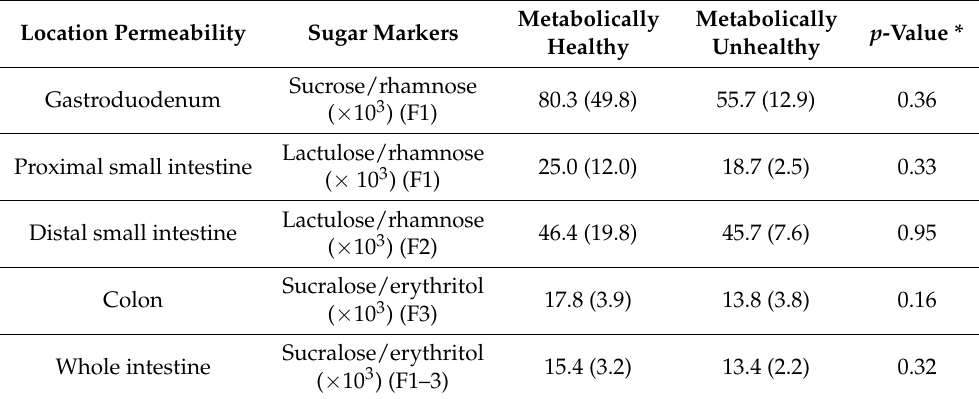
Table 2. Urinary sugar ratios of metabolically healthy ( n = 14) and metabolically unhealthy ( n = 14) subjects in the unchallenged MS permeability test.